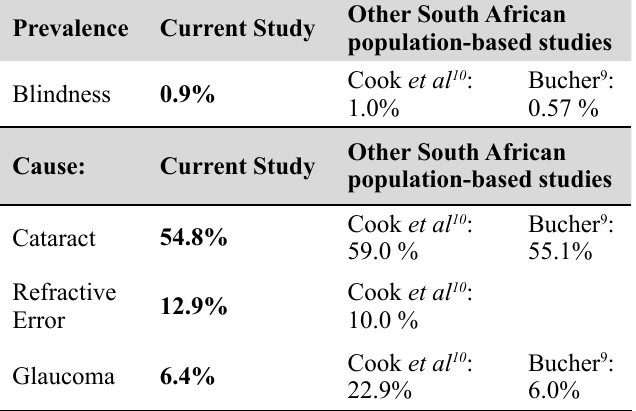
Table 1: Comparison of the prevalence of blindness found in the study with previous